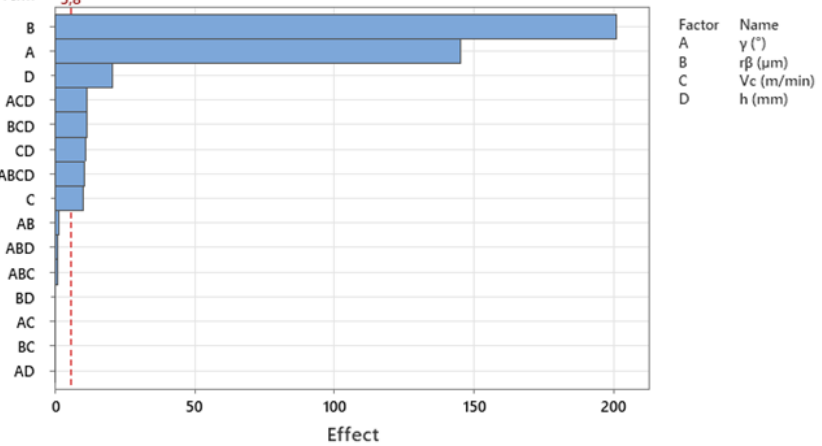
Figure 14. Pareto analysis of the factors affecting the residual stresses the longitudinal direction ( SRSL ) based on all cutting conditions.